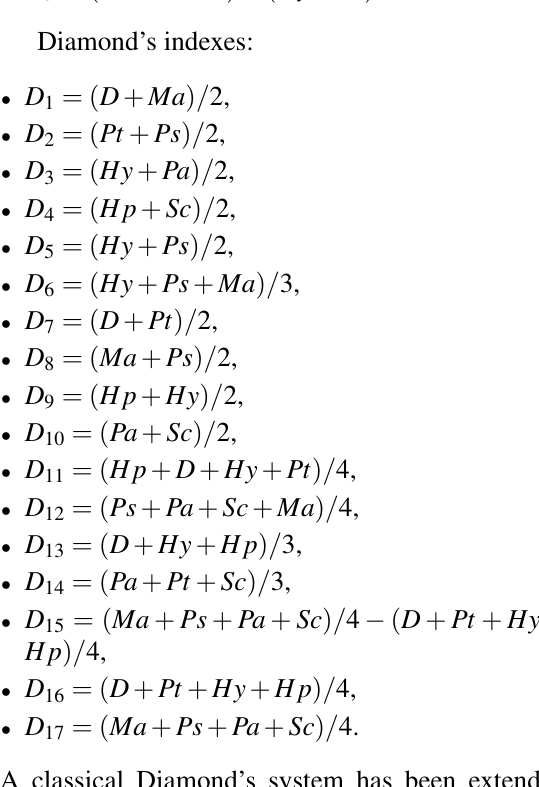
Figure 1: MMPI profile of a patient (example); suppressors +0.5K, +0.4K, +1K, +0.2K a correction value from raw results of scale K added to raw results of selected clinical scales • G 3 = ( L + Pa + Sc ) − ( Hy + Pt )